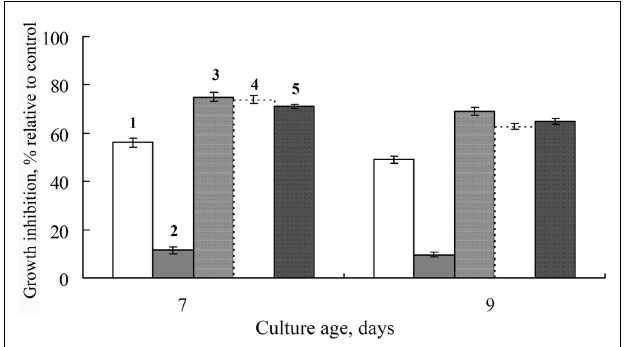
FIGURE 7 | Enhancement of Folicur growth-inhibitory effect against S. nodorum by co-application of the fungicide with filtrates of cultural liquid (FCL) produced by a biocontrol isolate, FS-94, of F. sambucinum after 7 or 9days of cultivation. ( 1) Folicur, alone, 0.25ppm; ( 2) FCL, 2 volume percent, alone; ( 3) Folicur, 0.25ppm + FCL, 2 volume percent; ( 4) Predicted percent of growth inhibition based on the sum of 1 and 2 ; ( 5) Folicur, 0.5ppm. Bars represent SE. Percent growth inhibition distinctions between treatments 1 and 3 are significant at p < 0.002 and 0.05 on 7th and 9th days, respectively. Differences between mean growth inhibitions of 3 and 4 on 9th day are significant at p <